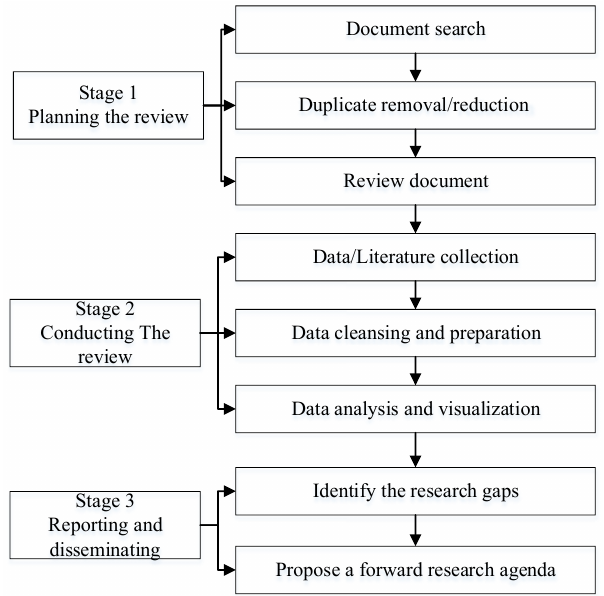
Figure 1. Overview of